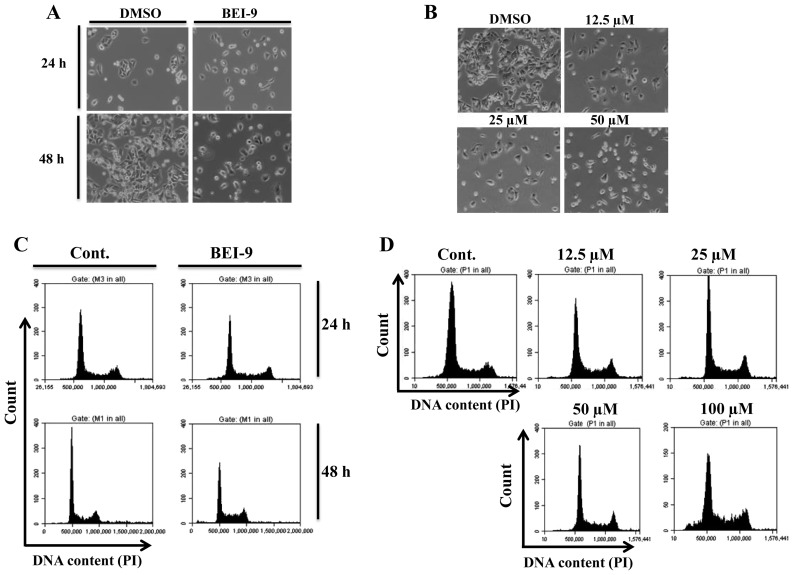
BEI-9 is an inhibitor of cell proliferation without induction of apoptosis. (A) SW480 colon cancer cells were exposed either to dimethyl sulfoxide (DMSO) as vehicle control or BEI-9 (50 µM). Phase-contrast images were captured at 24 (upper panels) or 48 h (lower panels). (B) SW480 colon cancer cells were exposed to DMSO as a vehicle control or to 12.5, 25, or 50 µM concentrations of BEI-9. Phase-contrast images of the cells were captured at 48 h after treatment. (C) Cell cycle of cells treated as in panel a, showing no induction of a sub-g1 population of cells, indicative of apoptosis. (d) Cell cycle profiles of cells exposed to the indicated concentrations of BEI-9 showing a small induction of sub-G1 cells only at a high concentration (100 µM). The x-axes of the histograms in both panels C and D indicate propidium iodide (PI) staining intensity, representing the DNA content of cells, whereas the y-axes indicate cell counts.